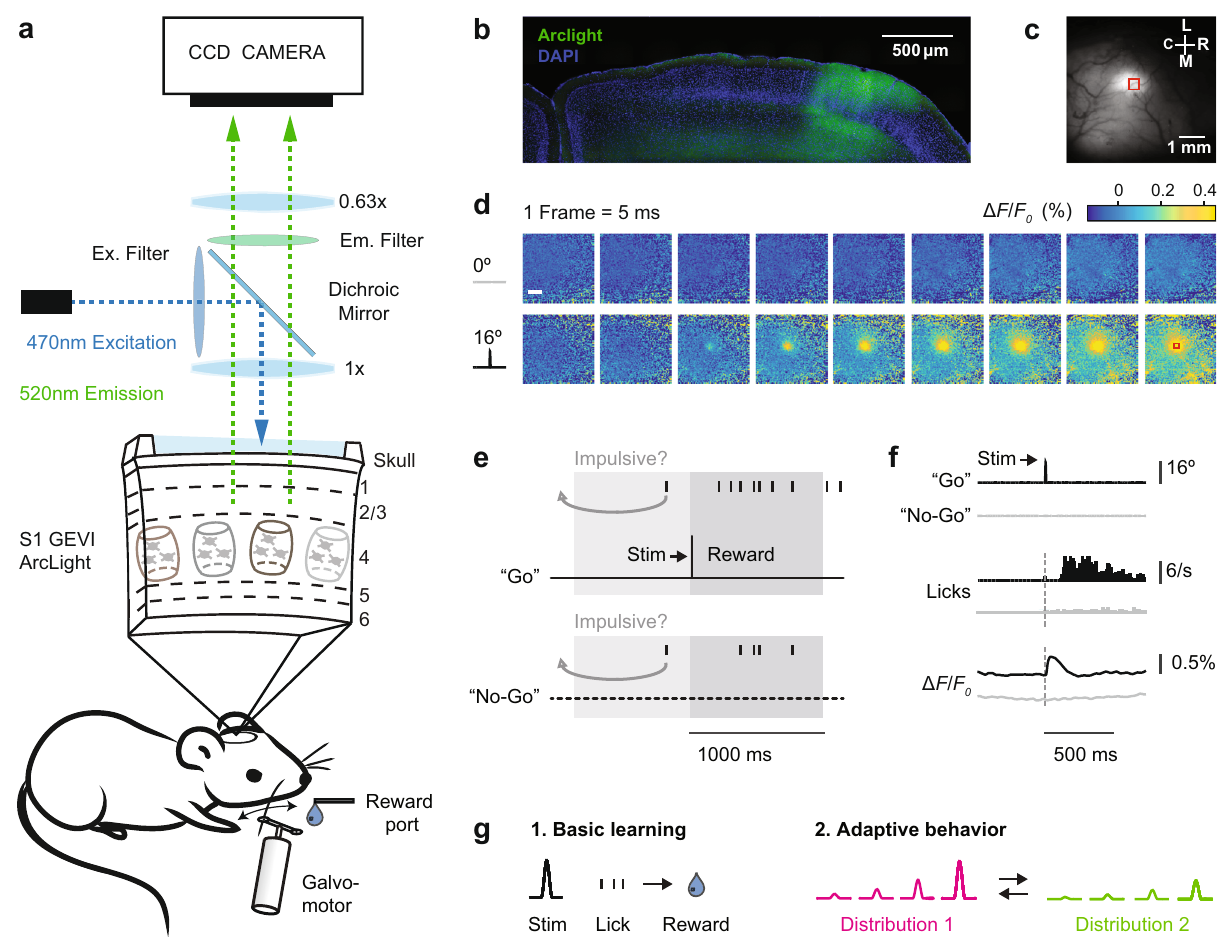
Fig. 1 Imaging and behavior methods. a Top: Schematic of the imaging system. The GEVI “ ArcLight ” is expressed in super fi cial layers of S1. Bottom: Schematic of the behavior setup. b Confocal image of a coronal mouse brain section (100 μ m, right hemisphere) showing the characteristic spread of ArcLight in S1. Blue: DAPI staining, Green: Arclight fl uorescence. c Top view of the same hemisphere in vivo showing ArcLight fl uorescence in S1. C = caudal, R = rostral, M = medial, L = lateral. d Images of the same hemisphere in a trained mouse with ArcLight fl uorescence color-coded. Punctate